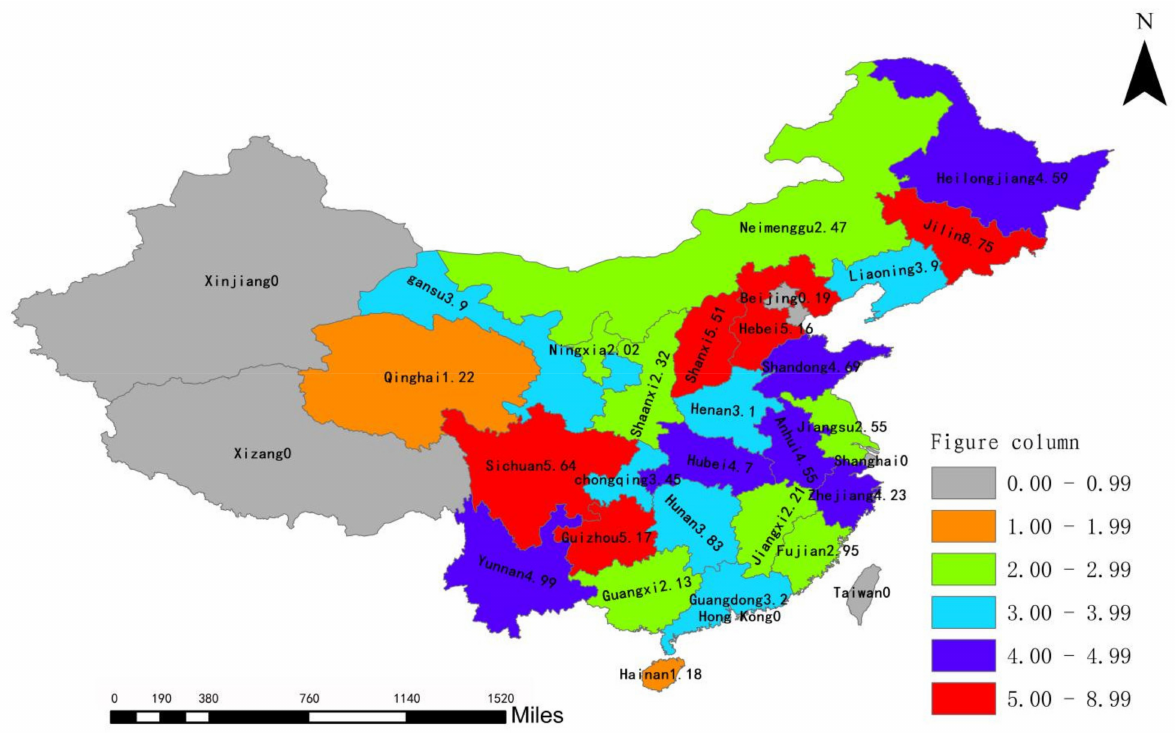
Figure 2. The distribution of samples in inter-provincial regions (%). Note: the distribution map of the sample provinces is drawn with ArcGIS 10.3